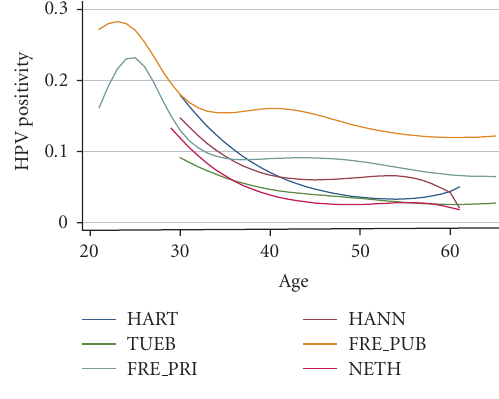
Figure 1: Age and HPV